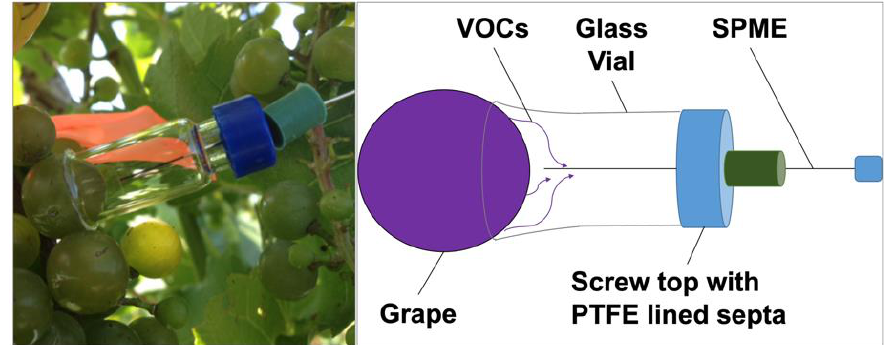
Figure 2. Non-destructive sampling of biogenic volatiles emitted by a modified 2 mL glass vial for a vacuum-assisted sampling of volatiles from a single grape berry. Schematic of a modified screw top 2 mL glass vial with PTFE lined septa used for characterizing in-vivo metabolite emissions from selected cold-hardy grapes. Negative pressure was created with a syringe to hold the sampling device with SPME sealed onto the grape berry surface.